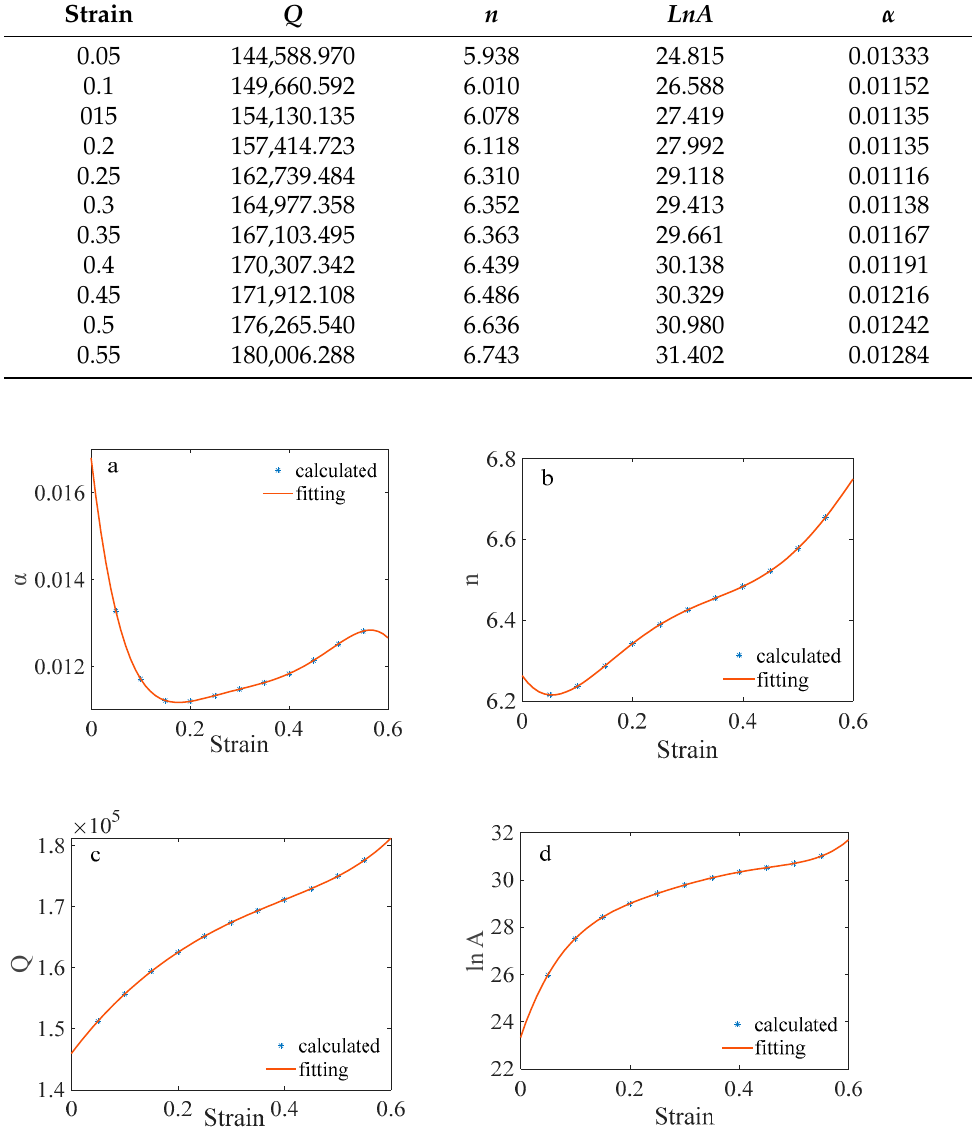
Figure 10. The fitting relationship curve between strain and material paraments: ( a ) Q — ε ; ( b ) n — ε ; ( c ) lnA — ε ; ( d ) α — ε .